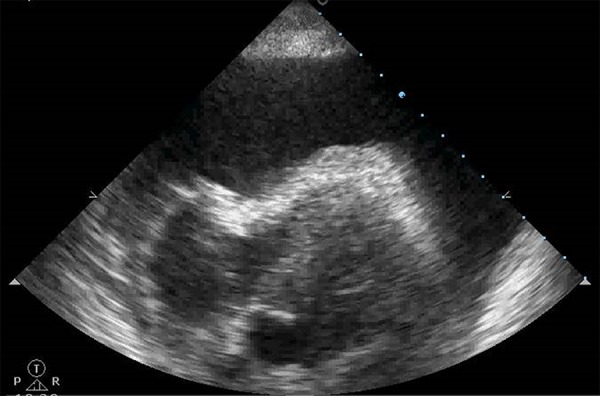
Cardiac tamponade.